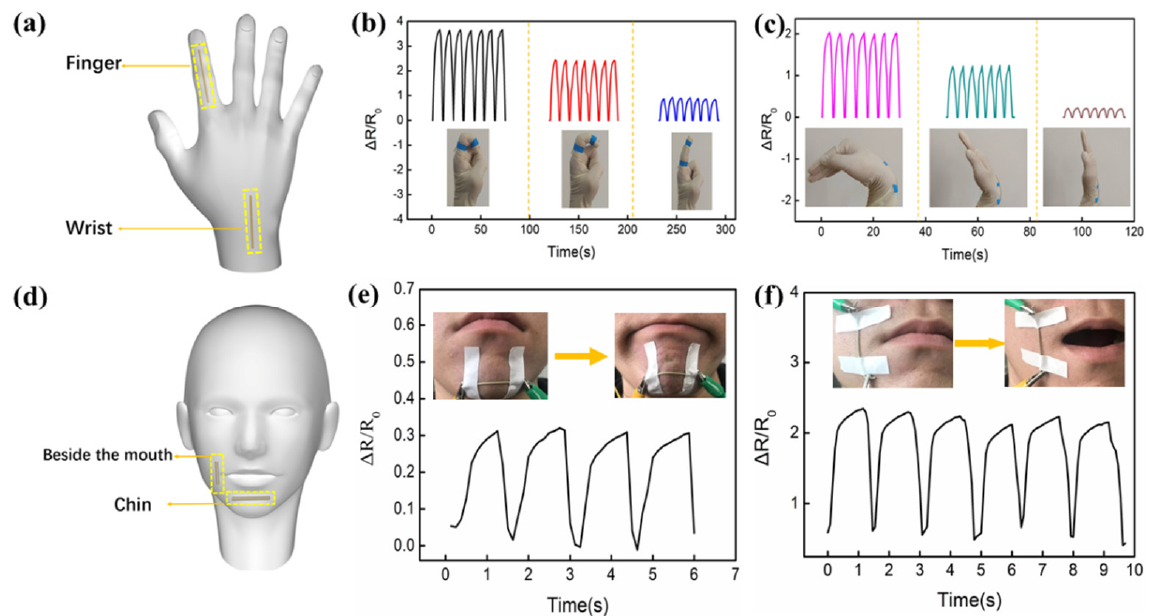
Figure 3. ( a ) The SPTS was fixed on a human finger and wrist for posture recognition. Dependence of the acquired electrical signals on the bending angles of ( b ) finger and ( c ) wrist. ( d ) The SPTS was attached on the facial skin for investigating relevant dynamic facial expression. Acquired electrical signals from ( e ) chin moving and ( f ) mouth opening.